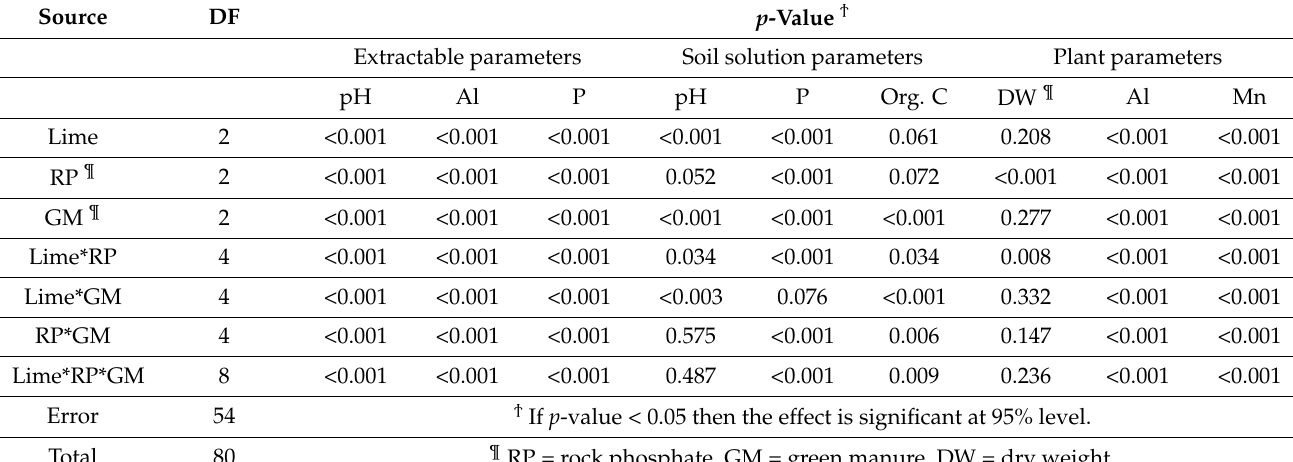
Table 1. Total nutrient contents of cowpea green manure, rock phosphate, and coral lime used in the